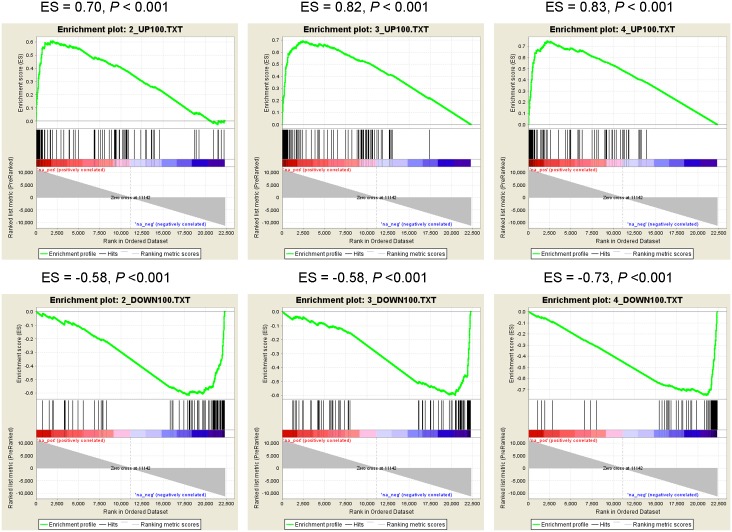
Gene Set Enrichment Analysis (GSEA) enrichment score curves of metformin-induced probes in three treatments vs. treatment 1.The four sets of probes of metformin treatments were obtained from the gene expression profiles from Connectivity Map. The three treatment instance IDs are 2, 3, and 4. The graphs on the top panels represent the ranked, non-redundant, and up-regulated probes in the second, third, and fourth treatment groups compared with probes in the first treatment group. The graphs on the bottom panels represent the ranked, non-redundant, and down-regulated probes in second, third, and fourth treatment groups compared with probes in the first treatment group. In each graph, probes on the far left (red) correlated with the most up-regulated probes in the treatment 1 and probes on the far right (blue) correlated with the most down-regulated probes in treatment 1. In each graph, the vertical black lines indicate the position of each of the probes of the studied probe set in the ordered, non-redundant data set. The green curve denotes the ES (enrichment score) curve, the running sum of the weighted enrichment score in GSEA.